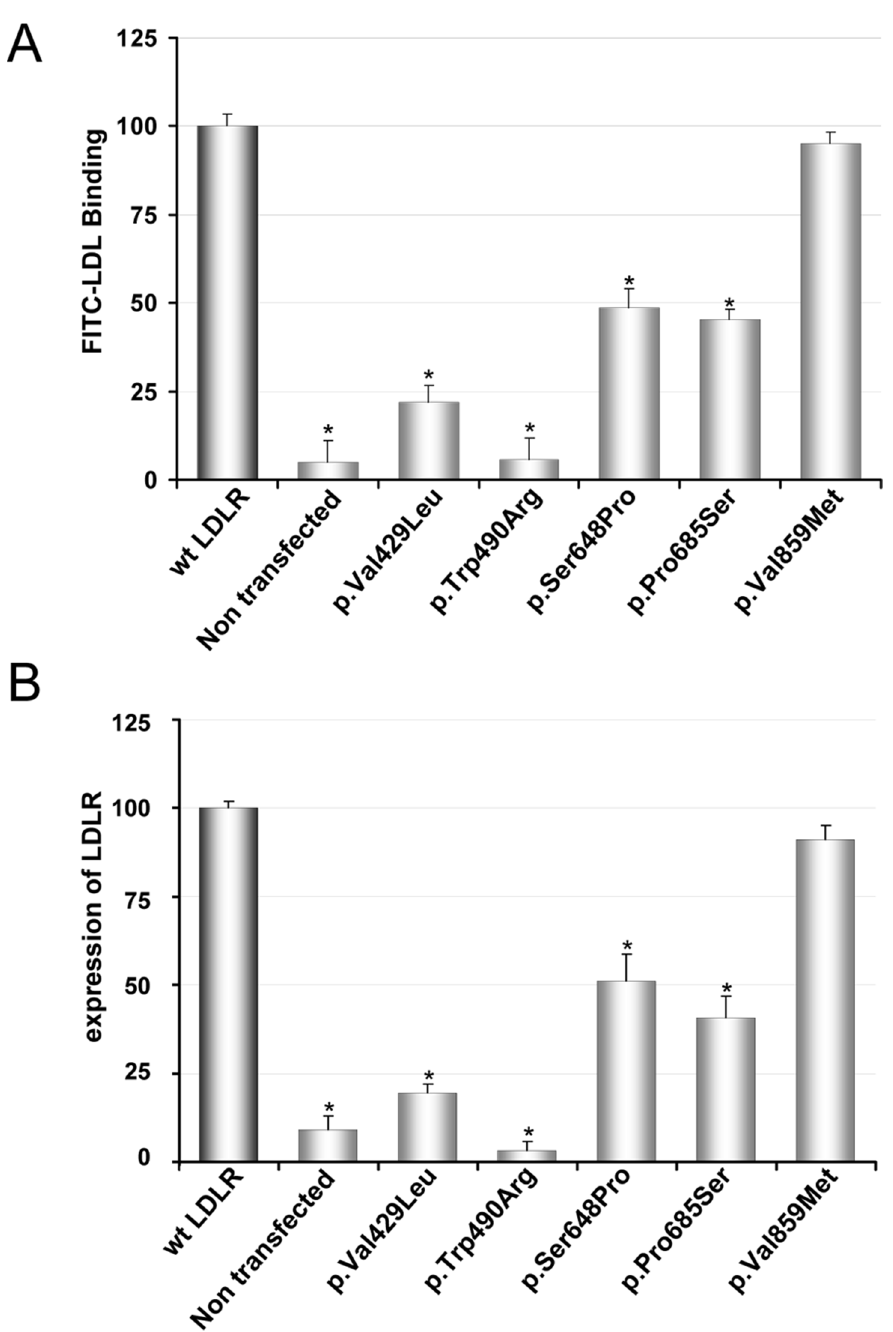
Figure 5. FITC-LDL binding and LDLR expression in CHO- ldlA7 transfected cells with wt or different LDLR variants. (A) For analysis of FITC-LDL binding, CHO- ldlA7 transfected cells with different LDLR variants were incubated for 4 h at 4 u C with 20 m g/mL of FITC-LDL as indicated. (B) For analysis of LDLR expression, transfected cells were incubated for 48 h and then the LDLR expression at cellular membrane was determined as described in Material and Methods. 10,000 cells were acquired in a Facscalibur and values of LDL uptake were calculated as described in Material and Methods. The values represent the mean of triplicate determinations (n=3); error bars represent 6 SD. *p , 0.001 compared to LDLR wt using a Student’s t-test.